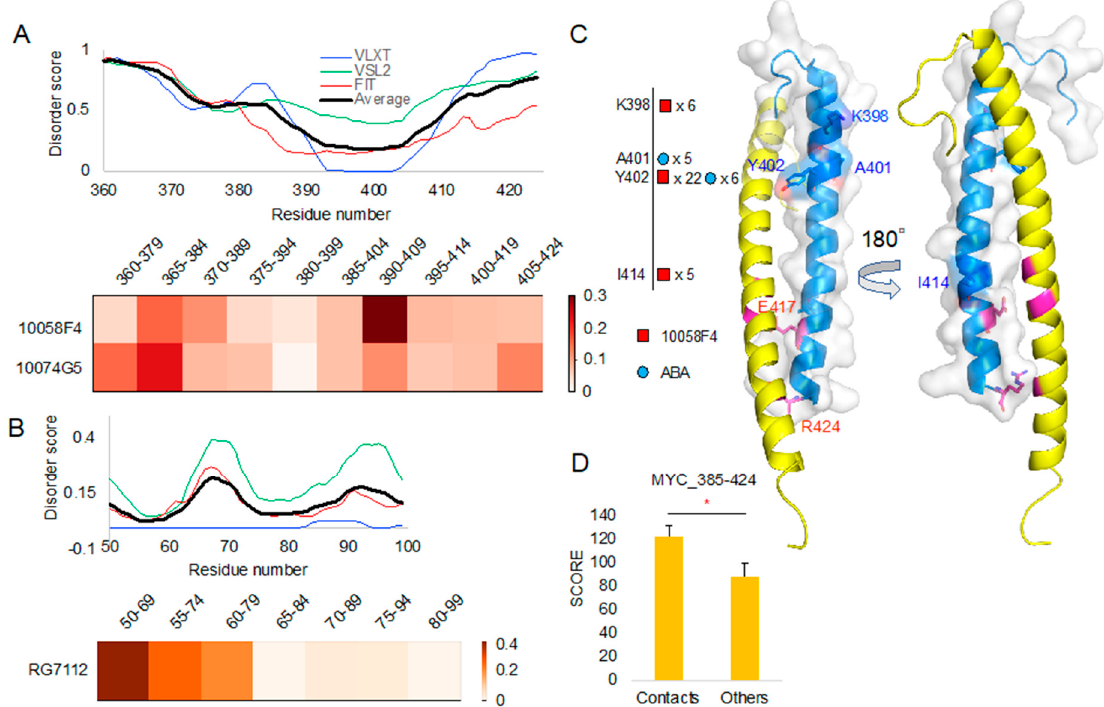
Figure 3. A protein intrinsic disorder score plot of peptide docking region and the corresponding region docking T score heatmap (normalized T scores): ( A ) MYC protein intrinsic disorder score and corresponding region T score heatmap of 10058F4 and 10074G5. ( B ) MDM2 protein intrinsic disorder score and corresponding region T score heatmap of RG7112. ( C ) MYC contact residues shown on MYC–Protein max (MAX) complex structure (PDB ID 1NKP) [13]. ( D ) T -test on the new docking evaluation score ( y -axis) between contact mapping cases and others. * p -value < 0.001.